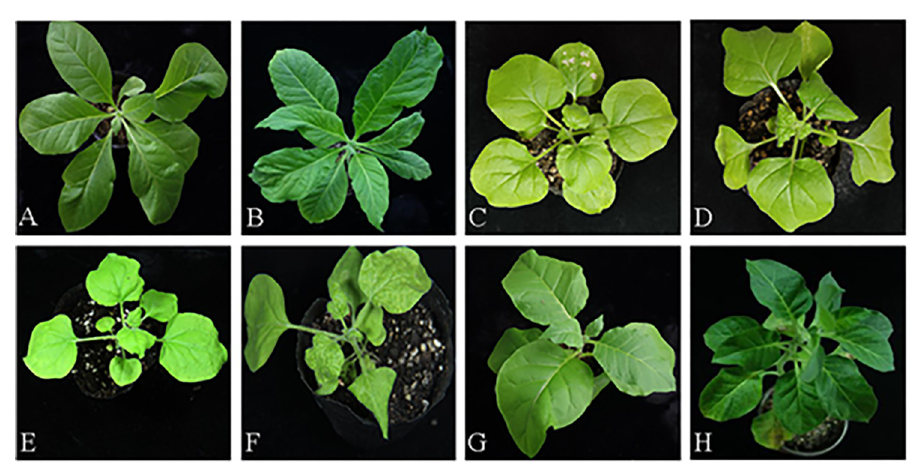
Fig 4. Inoculation test. A, B: Inoculation test of TMV. A: Control group; B: Experimental Group; C, D: Inoculation test of ToMV. C: Control group; D: Experimental Group; E, F: Inoculation test of CGMMV. E: Control group; F: Experimental Group; G, H: Inoculation test of PMMoV. G: Control group; H: Experimental Group.